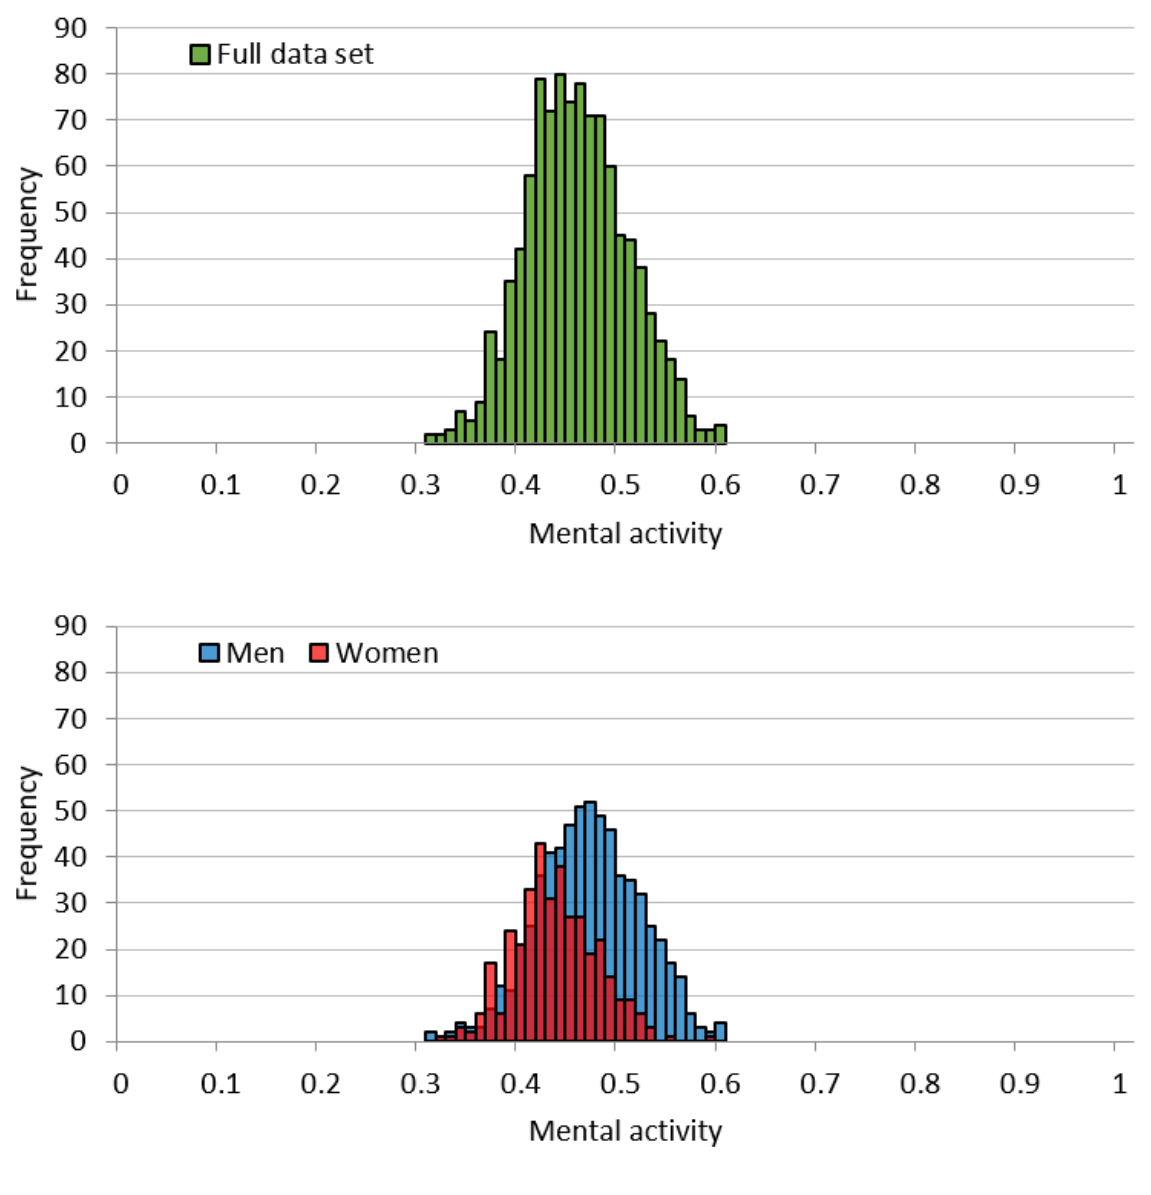
Figure 5. User dataset mental activity distribution for the full set and by